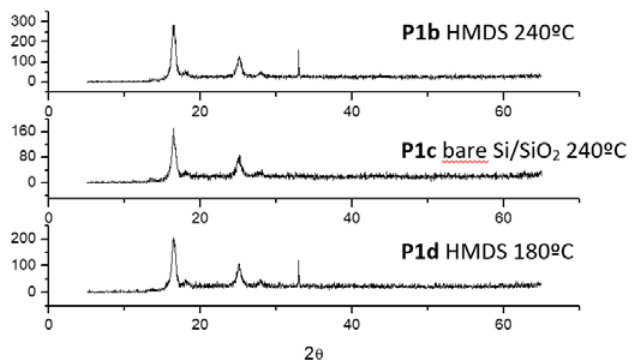
Figure 7. X-ray diffraction scans of vapor-deposited P1b , P1c , and P1d thin films. Optimal deposition conditions are indicated in the graph.